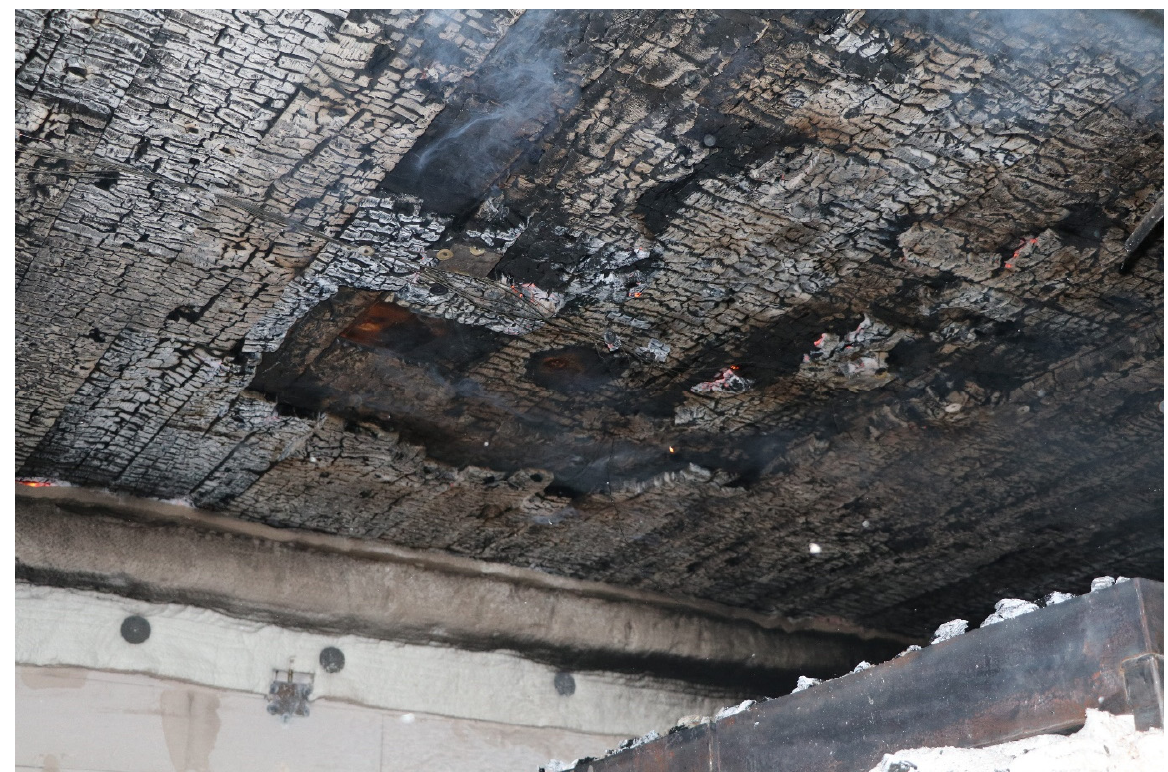
Figure 19. CLT soffit post-experiment in proximity to burner array in Experiment 2.